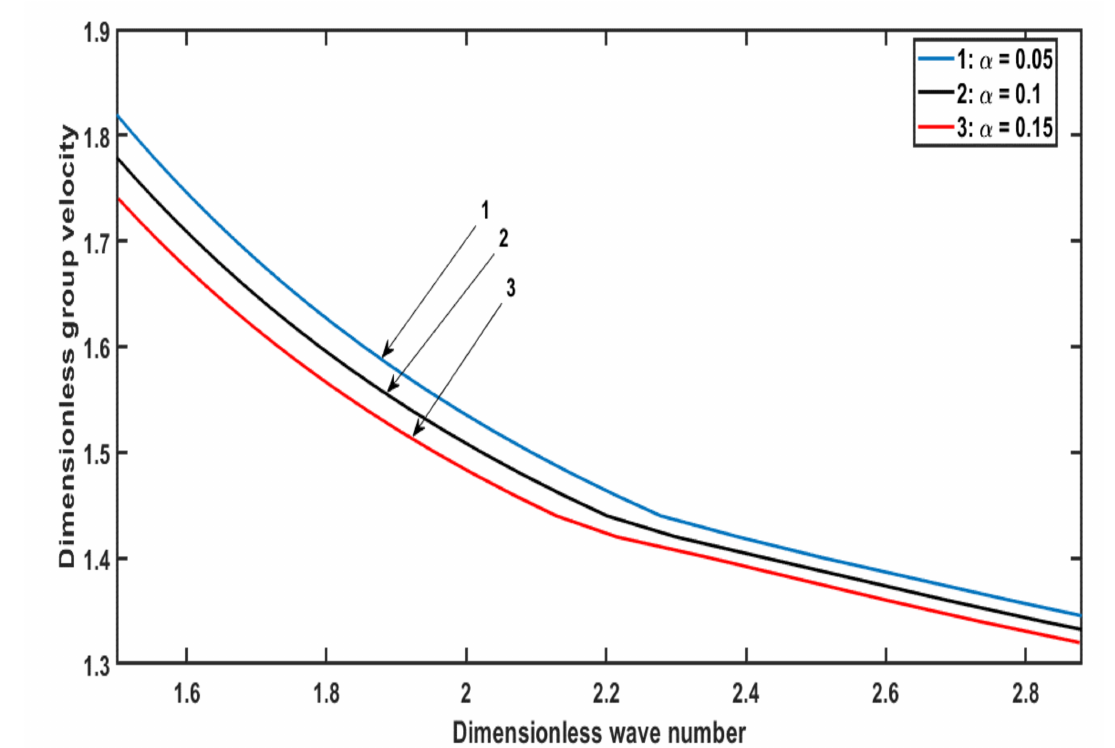
Figure 11. The group velocity with wave number when a 1 = 0.1, p = 0.01, m = 0.08, h = 0.04, a 2 = 0.2, β = 0.1.